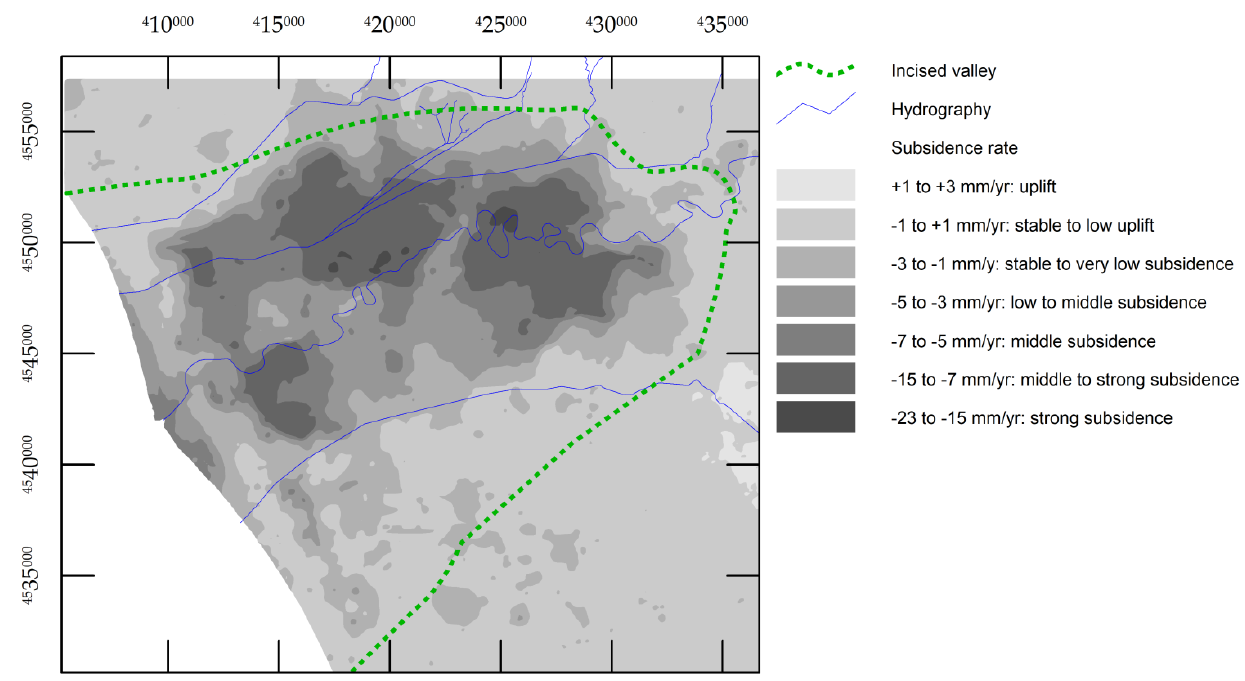
Figure 6. Cumulative vertical ground displacement estimated during 1992–2010 (based on Matano et al., 2018).